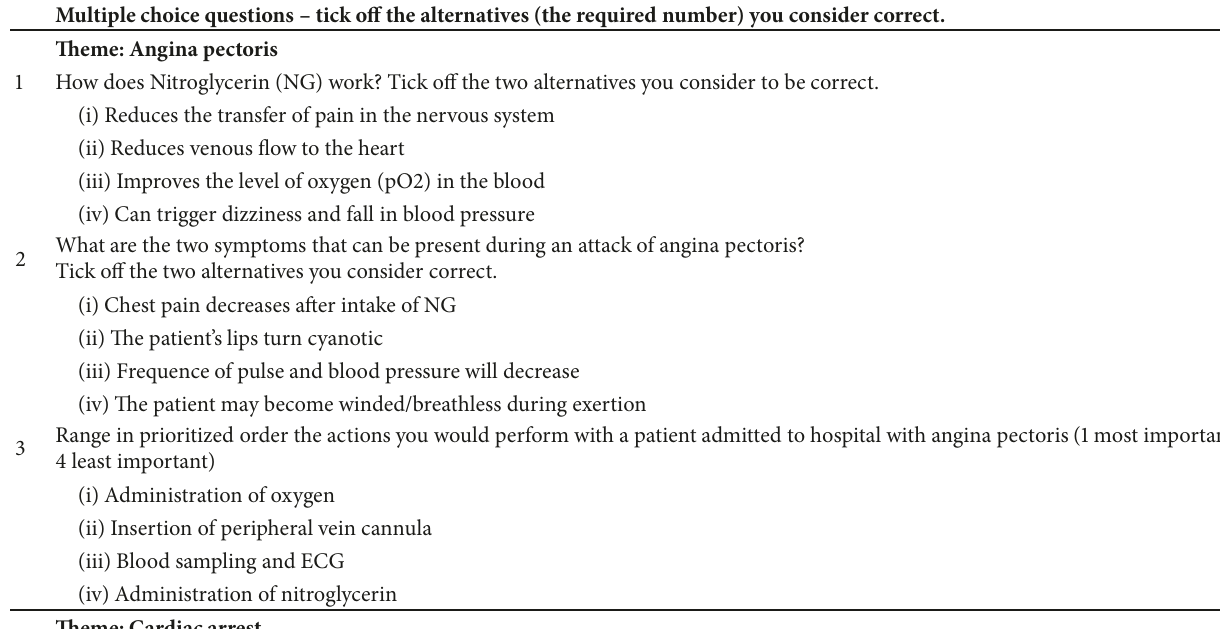
Table 2: Multiple-choice